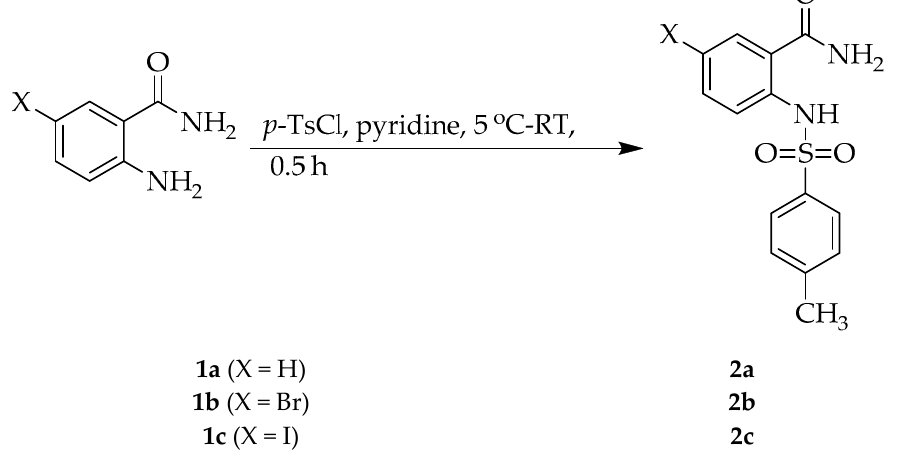
Scheme 1. Sulfonylation of anthranilamide derivatives 1a – c